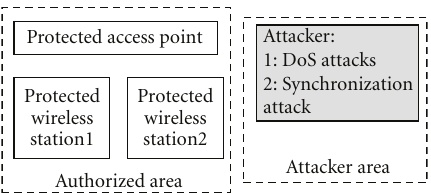
Figure 4: Simulation environment B for the ACFNC